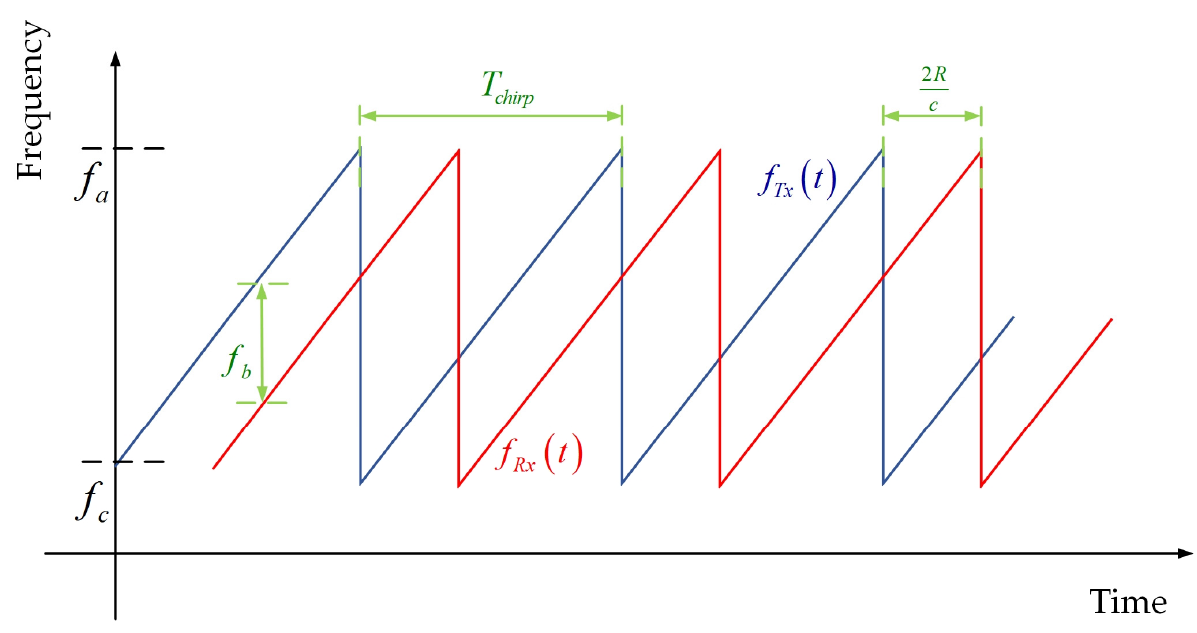
Figure 1. Normal pattern of mmWave FMCW radar.